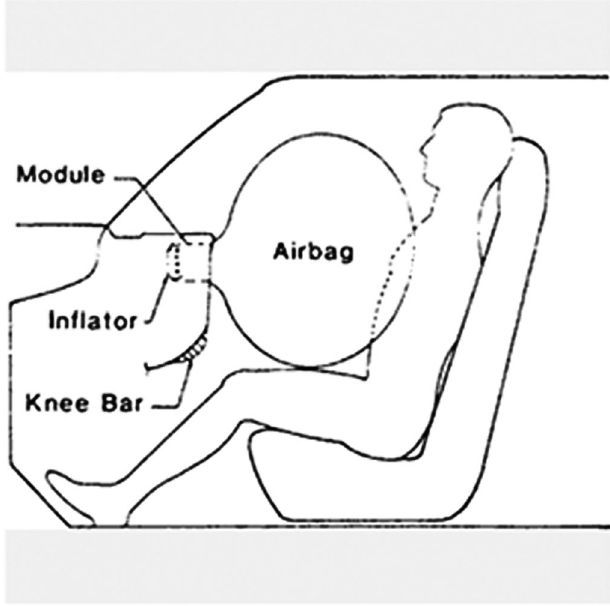
FIG. 10. Diagram of a rod used in lesson